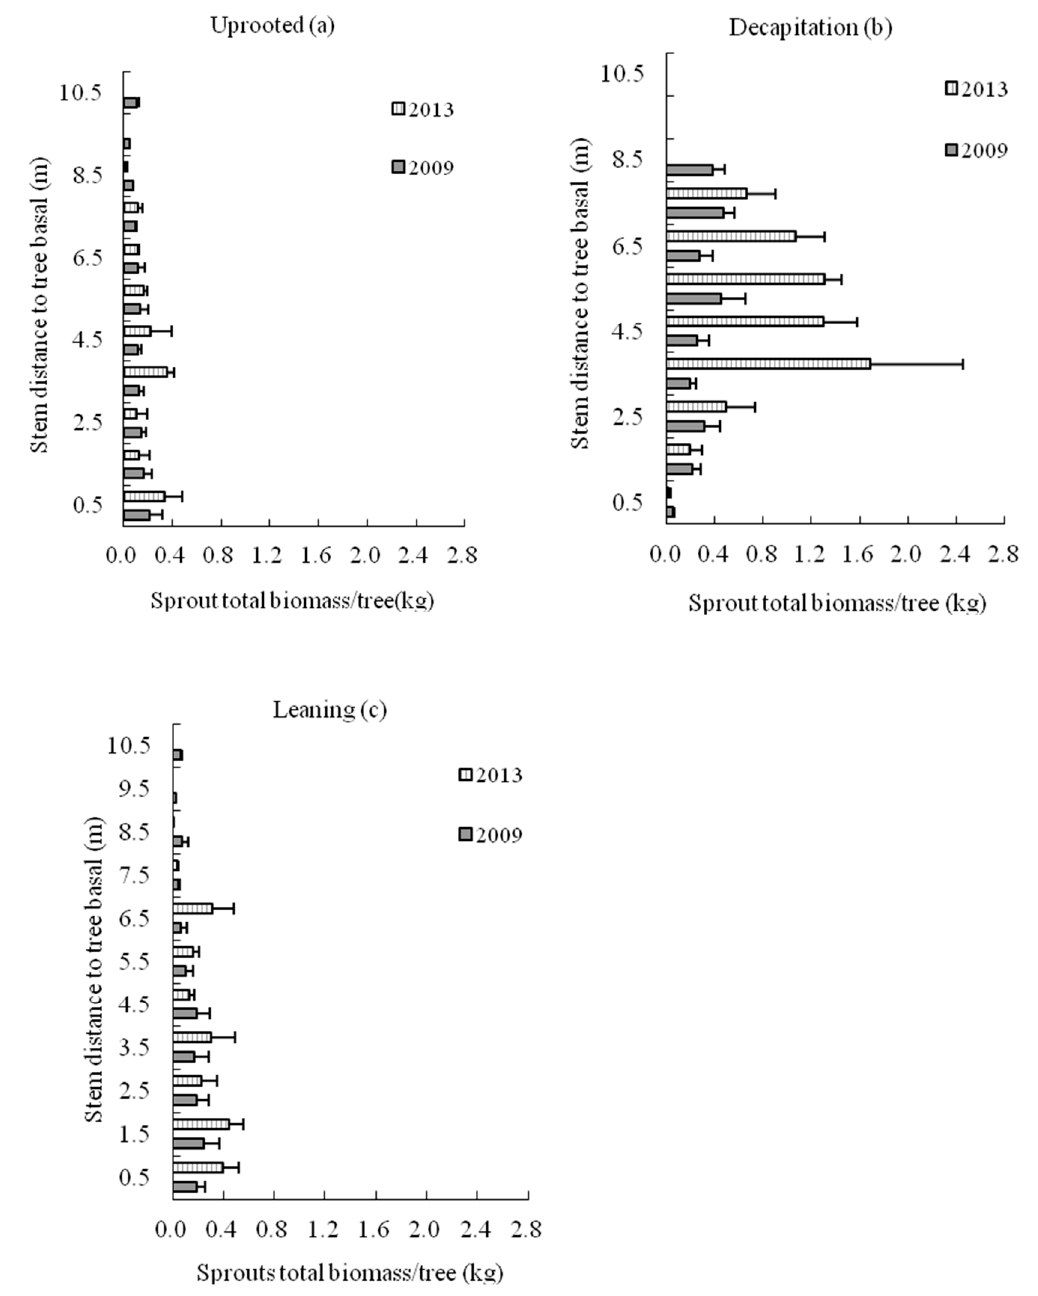
Figure 9. The sprout biomass distribution on ( a ) uprooted, ( b ) decapitation and ( c ) leaning tree stems of Schima superba in 2009 and 2013, respectively.